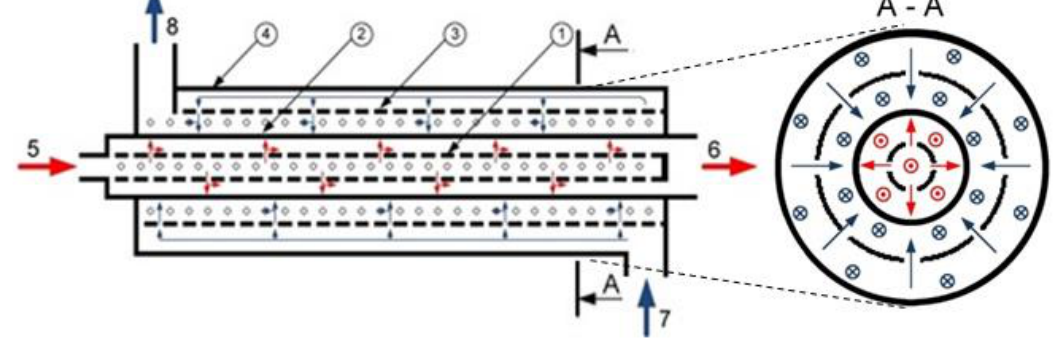
Figure 1. The minijet heat exchanger (MJHE) — schematic diagram.